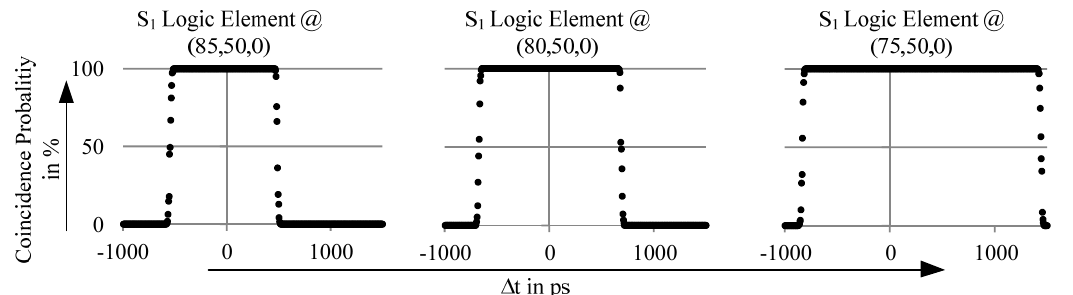
Figure 10. Comparison of different feedback path lengths for CDL 6. The S 2 logic element resides at position (90,50,0). Thus the feedback path length is 5, 10, 15 columns of logic elements inside the Cyclone IV FPGA (from left to right).